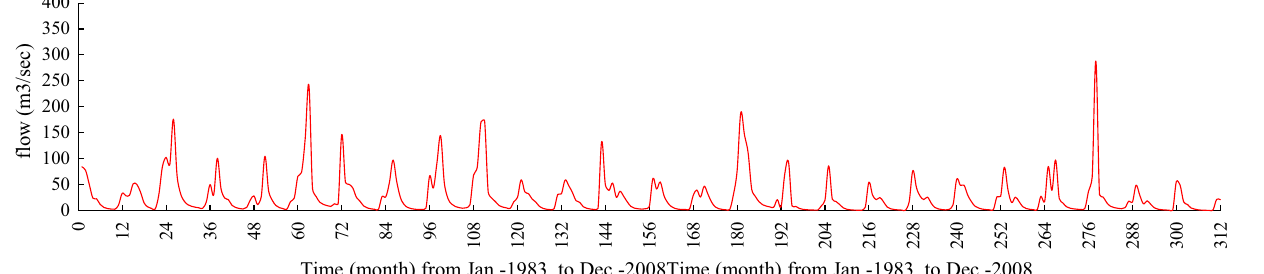
Fig. 17 Monthly simulated runoff contribution by Hemren dam reservoir catchment area for the period 1983–2008